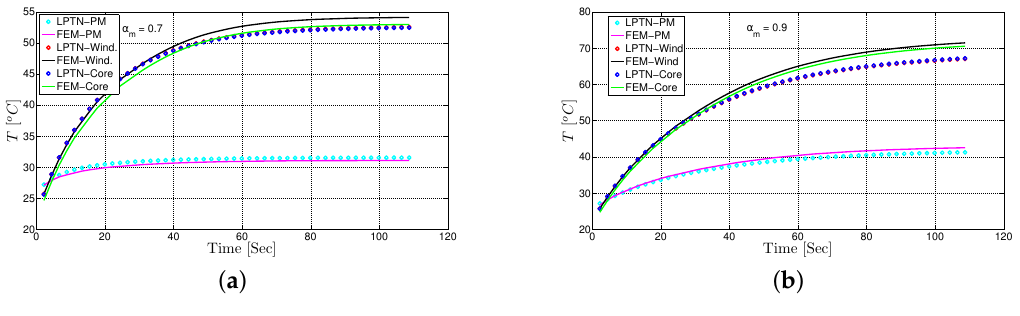
Figure 12. Machine temperature at ( a ) α m = 0.7; ( b ) α m = 0.9.